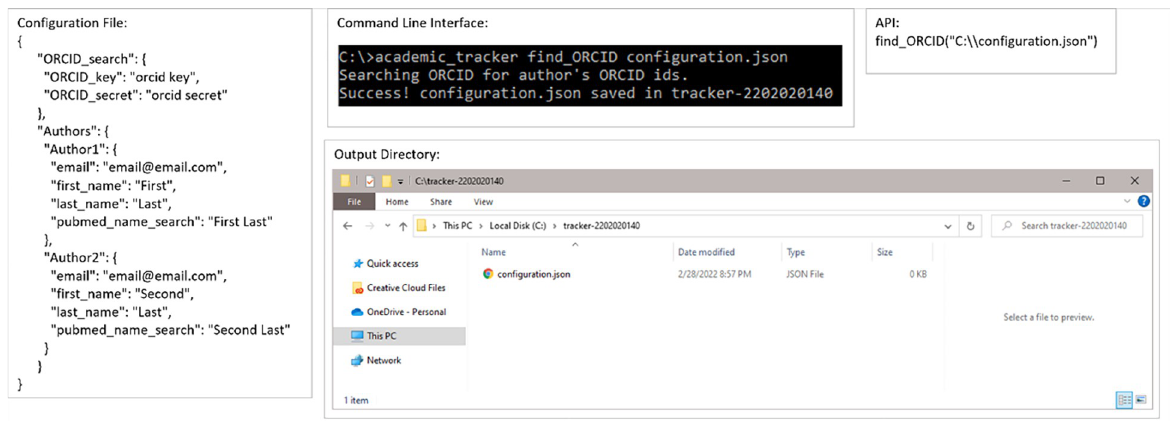
Fig 9. Example execution of the ORCID ID search use-case. Example configuration file, command-line execution, API execution, and file output of the author ORCID ID search use-case shown.